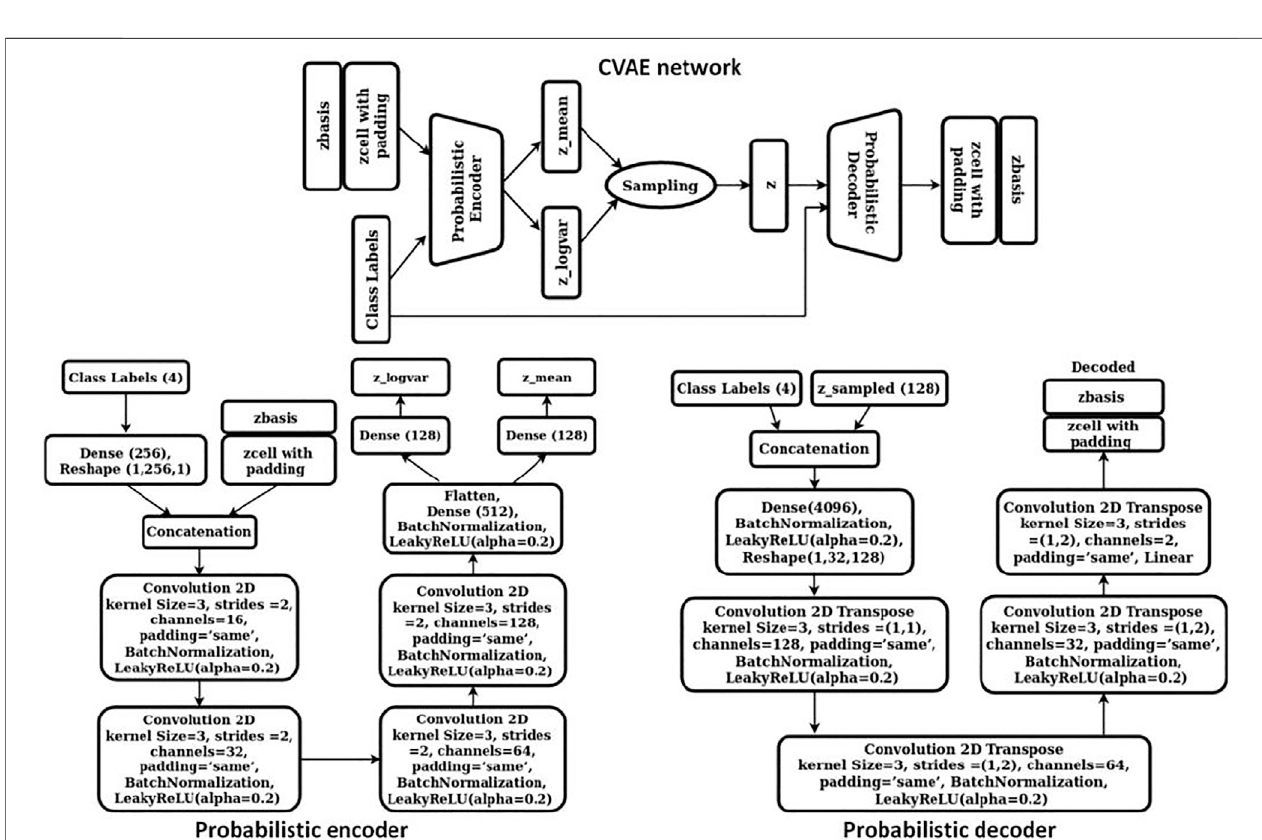
FIGURE 4 | CVAE network